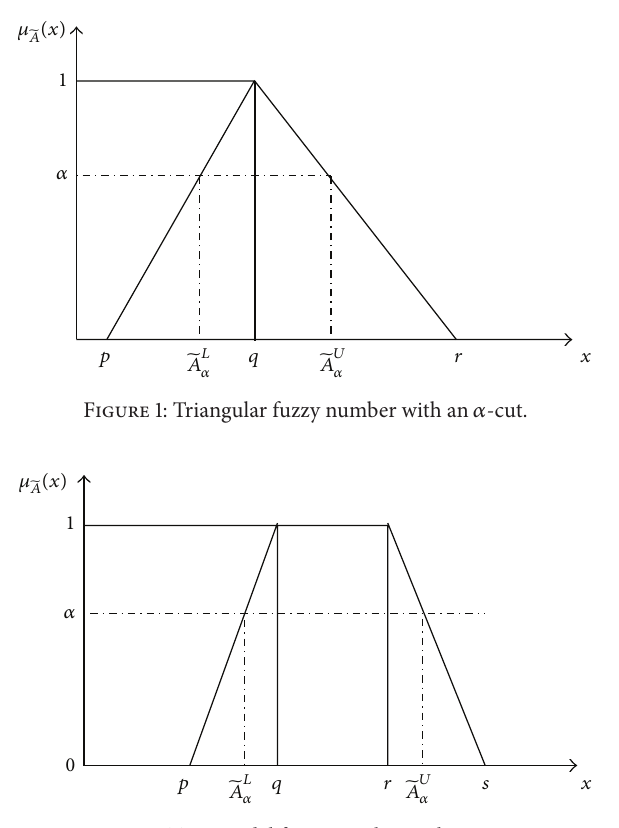
Figure 2: Trapezoidal fuzzy number with an 𝛼 -cut.